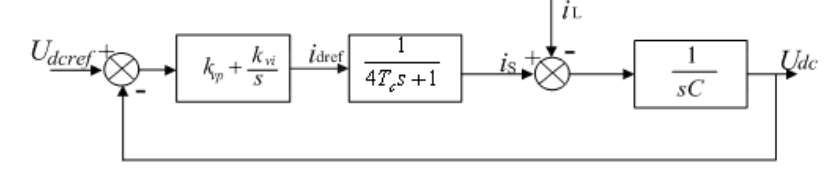
Figure 7. Simplified dynamic block diagram of voltage loop.